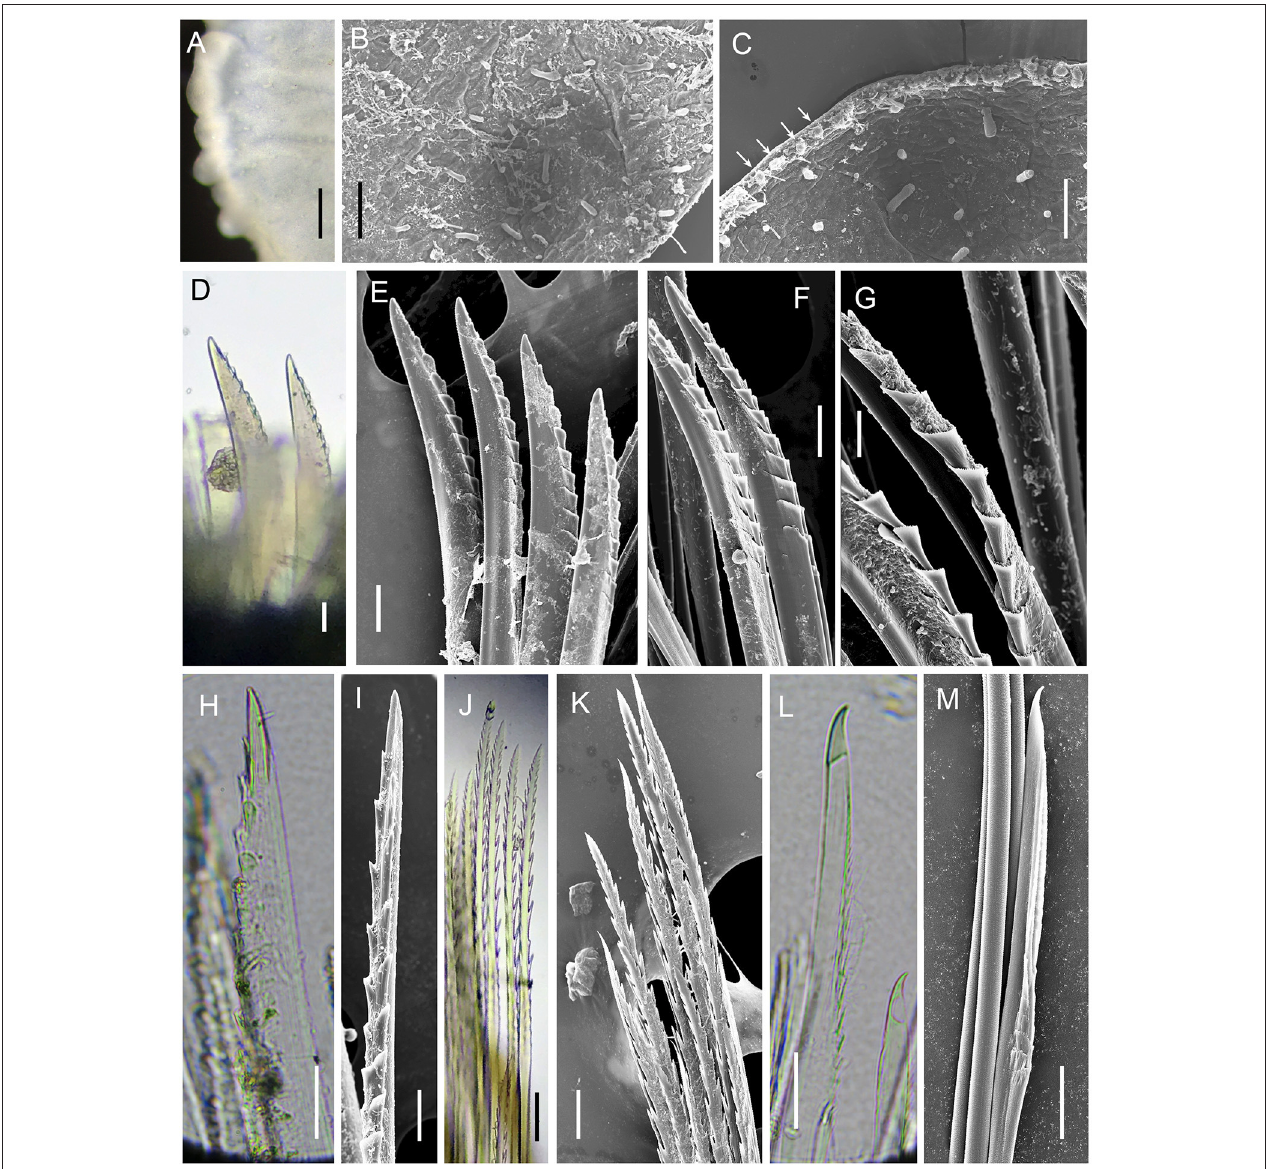
FIGURE 6 | Levensteiniella undomarginata sp. nov. Details of scale and chaetae. All the materials are from Paratype 5. (A–C) micropapillae on the elytral surface. Arrows in (C) show micropapillae along the edge. (D,E) , shorter notochaetae on the dorsal side. (F,G) longer notochaetae in the middle. (H,I) notochaetae from the lower ventral side. (J,K) upper neurochaetae. (L,M) lower neurochaetae. D to M are all from right segment 11 parapodium. Scale bar: (A) 250 µ m; (B) 80 µ m; (C) 60 µ m; (D,E,J,K) 30 µ m; (F,H,I) 20 µ m; (G,L,M) 10 µ